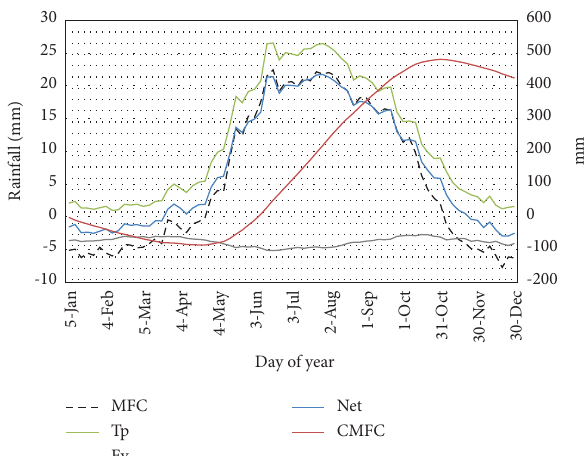
Figure 10: Climatology time-series of ERA-5 daily atmospheric moisture budget averaged over 10–30 ° N, 90–105 ° E during 1991–2020, showing the total precipitation (solid green), evaporation (solid grey), MFC (dotted black), net precipitation (solid blue), and CMFC (red).